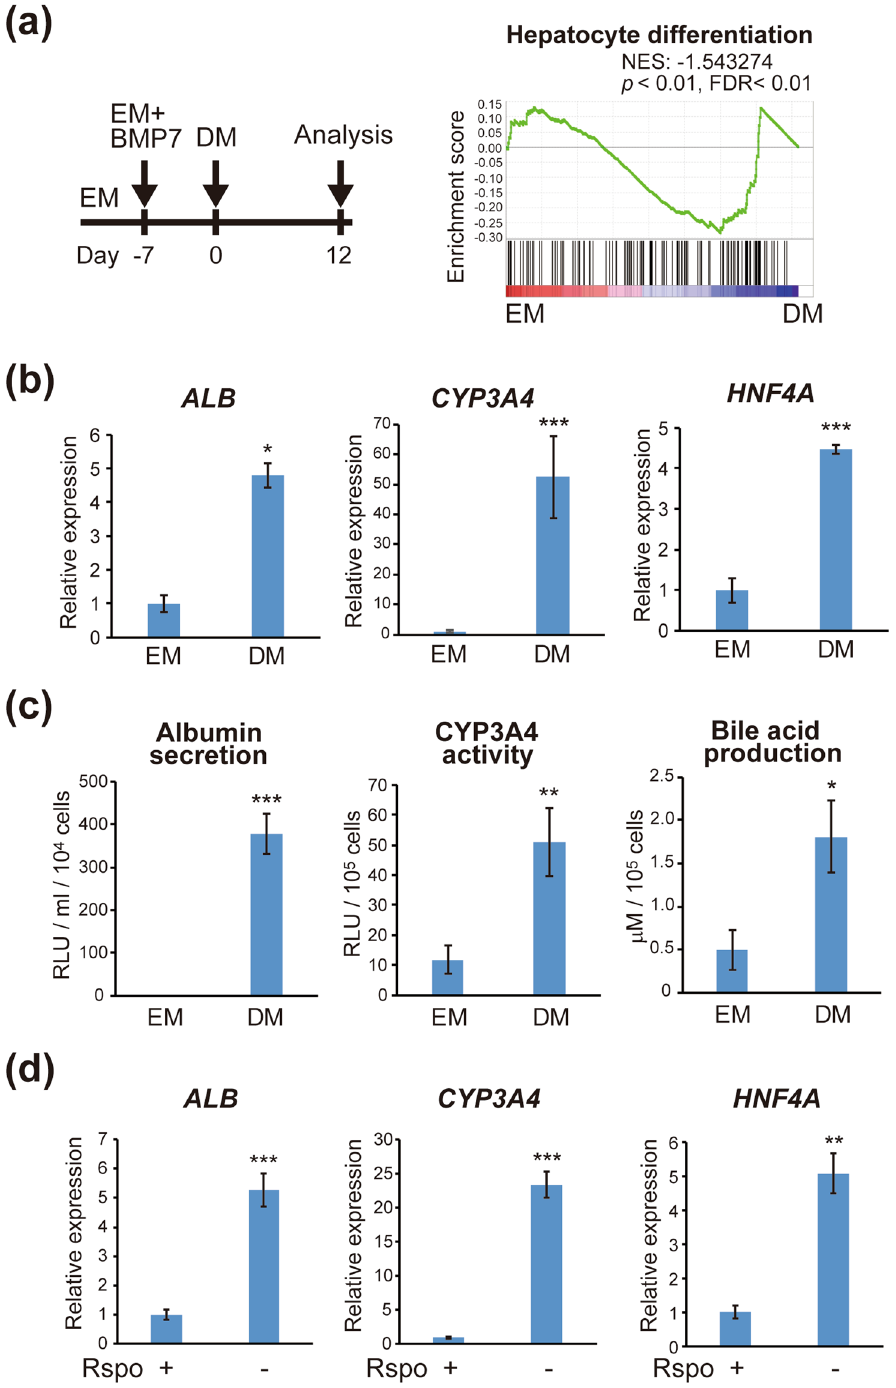
Figure 2. Induction of differentiation of IHCC organoids to functional hepatocytes. ( a ) Schedule for hepatocyte differentiation using IHCC organoids. IHCC organoids were cultured for 7–10 days in EM additionally supplemented with BMP7. Then, the culture medium was changed to DM. DM was changed every 2–3 days for a period of 12 days. GSEA was performed using a ‘hepatocyte differentiation’ gene set. IHCC organoids cultured in DM have a strongly enriched hepatocyte differentiation signature ( p < 0.01, FDR <